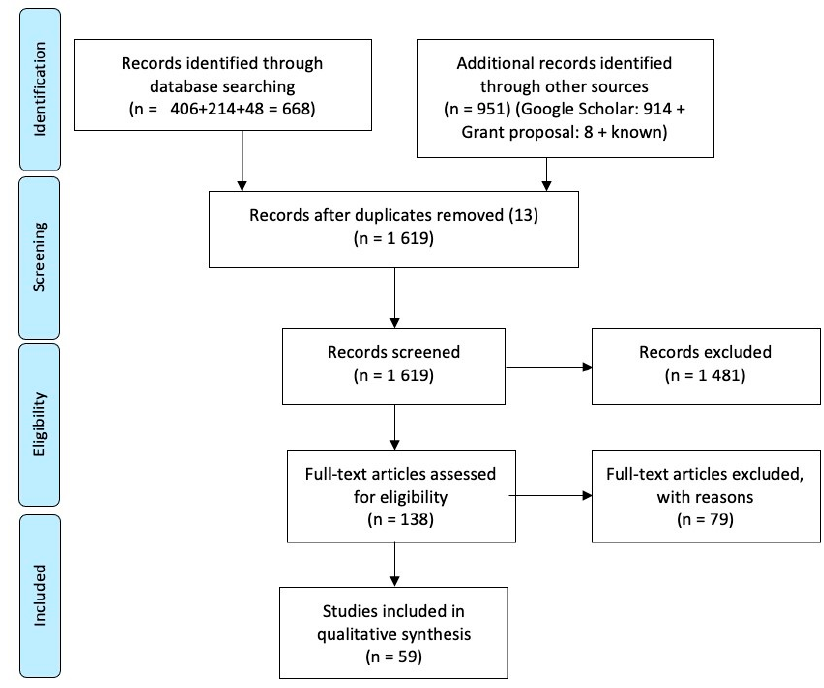
Figure 1. PRISMA flow diagram.